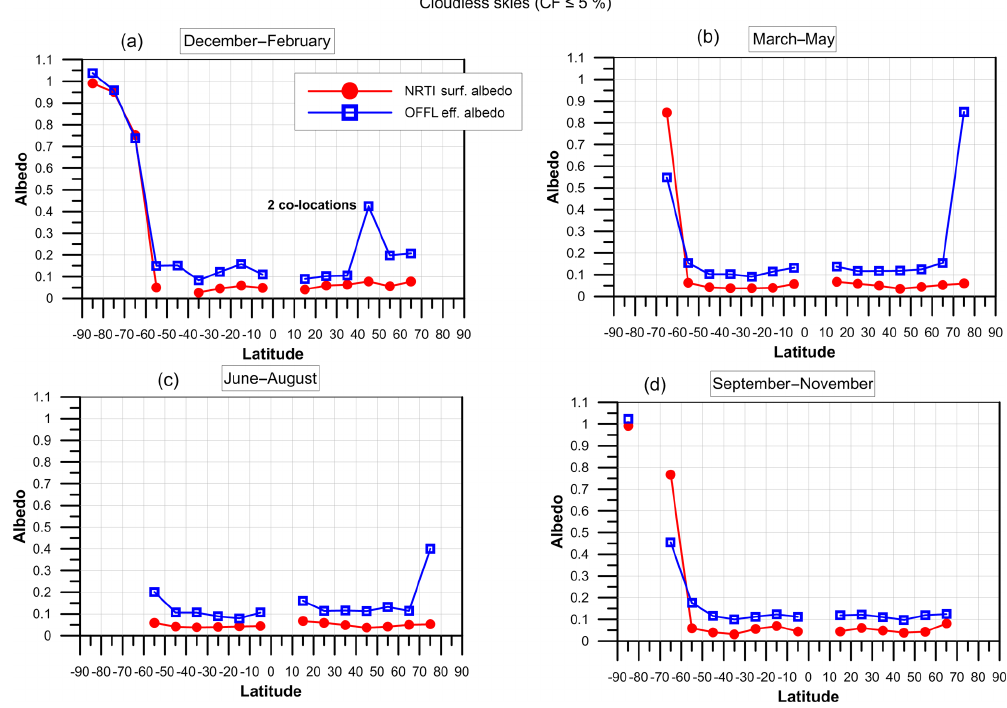
Figure 8. The albedo parameter that was used in the TOC retrieval of the two TROPOMI products. The red dots and line represent the surface albedo used in the NRTI algorithm. The blue squares and line represent the effective albedo used in the OFFL algorithm. The albedo parameter is plotted versus latitude and averaged in 10 ◦ bins for four different seasons (a–d) . Only cloudless co-locations (i.e., with cloud fraction < 5%) are considered for the